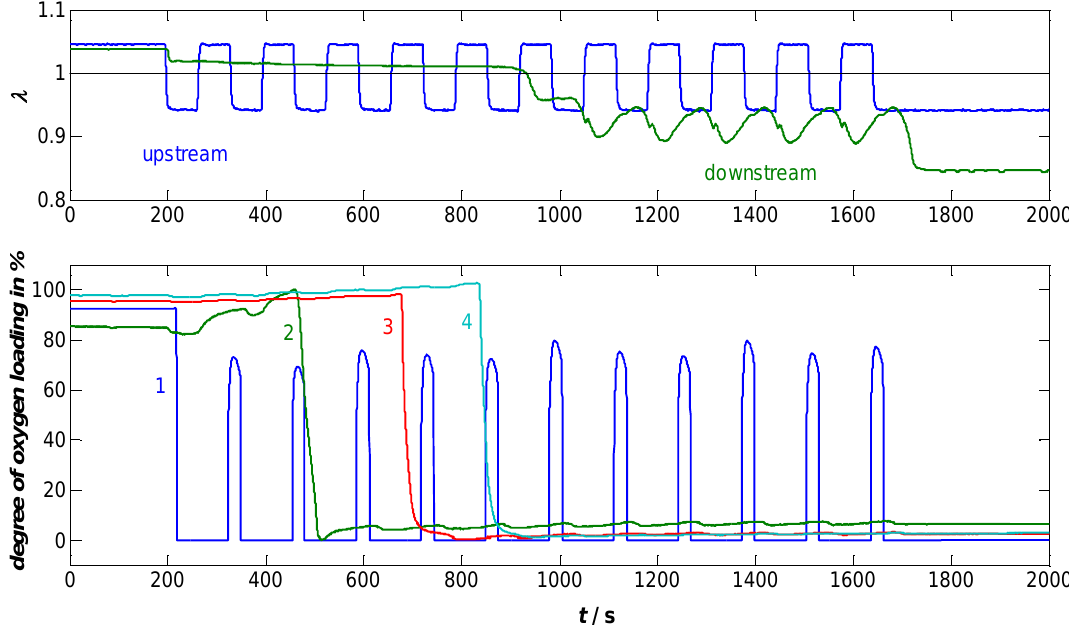
Figure 2. Oxygen loading experiment with the setup of Figure 1. Air-to-fuel ratio, measured by lambda probes (top). Sensor conductivity expressed in terms of % oxygen loading (bottom). Modified and recalculated using data from